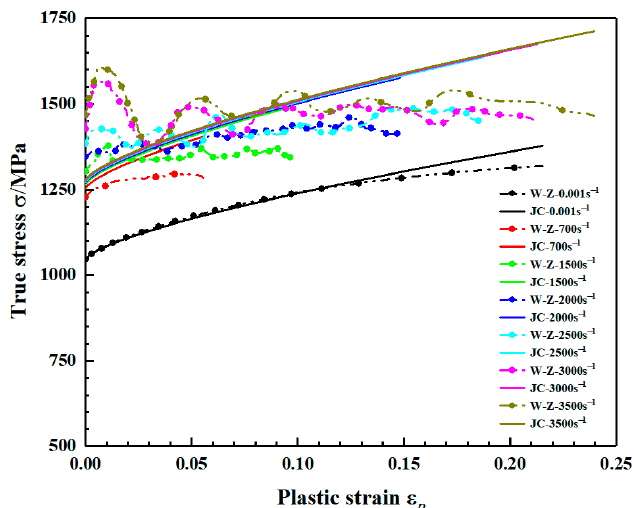
Figure 19. Comparison of flow stresses in the J–C model and experiments (deposition direction).